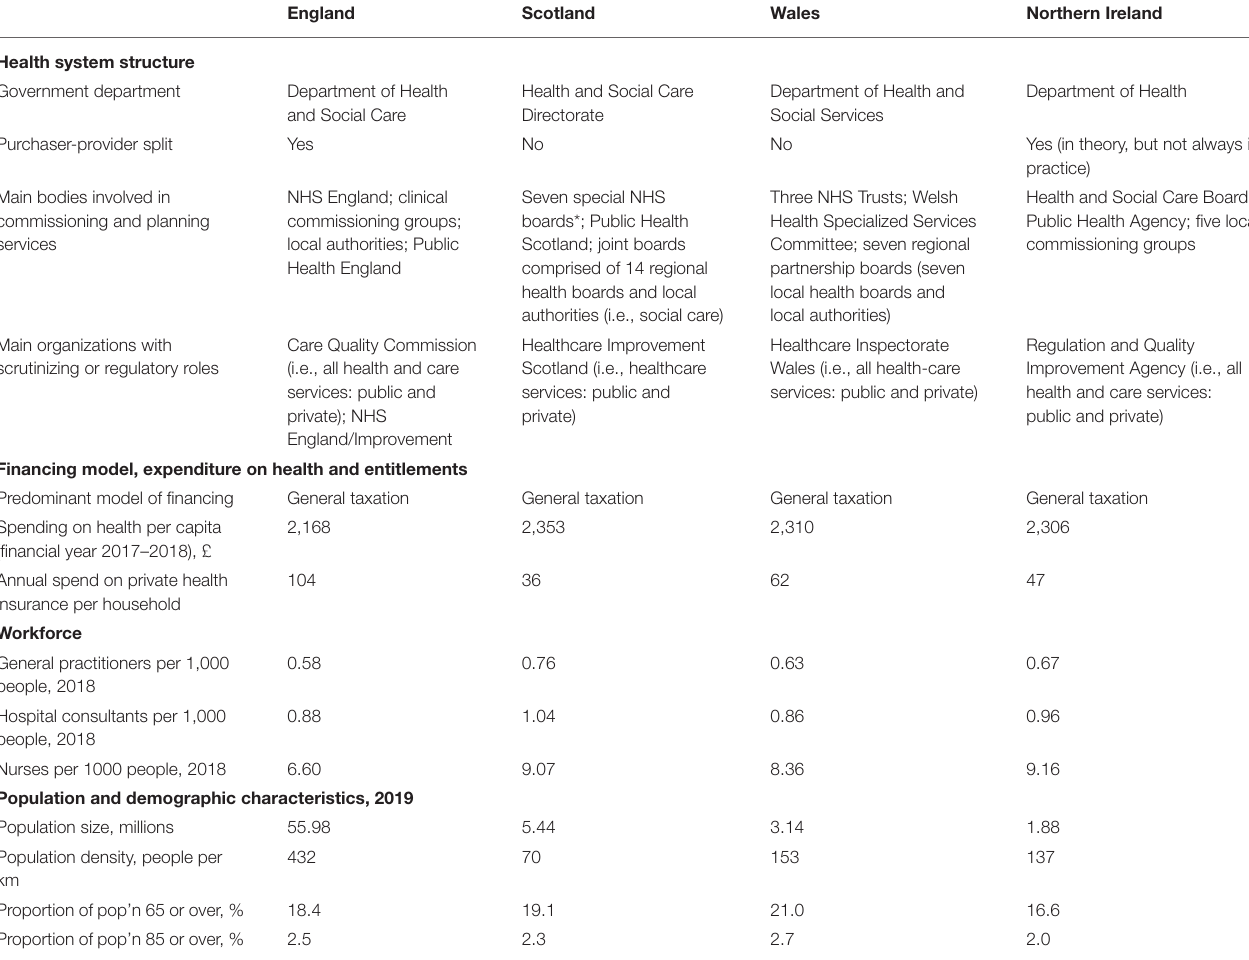
TABLE 1 | Overview of the structure of health systems and selected health and healthcare indicators in each of the UK four